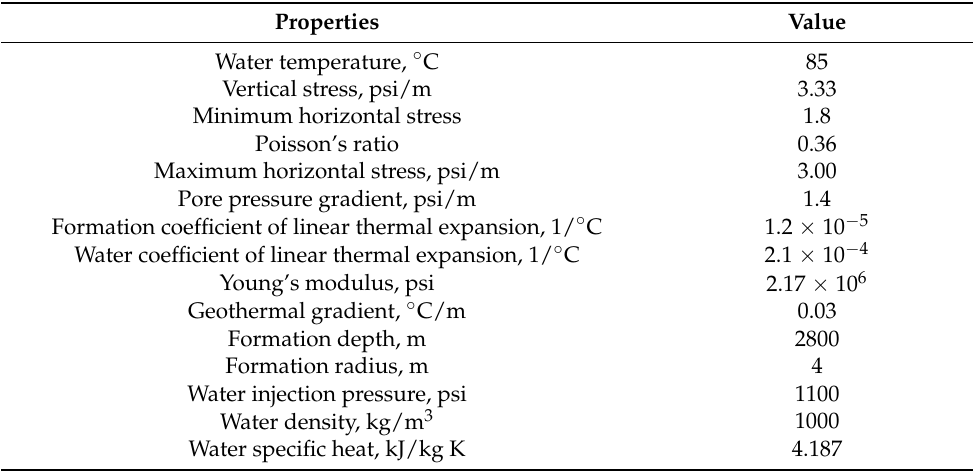
Table 8. Formation and Water properties used in geomechanics